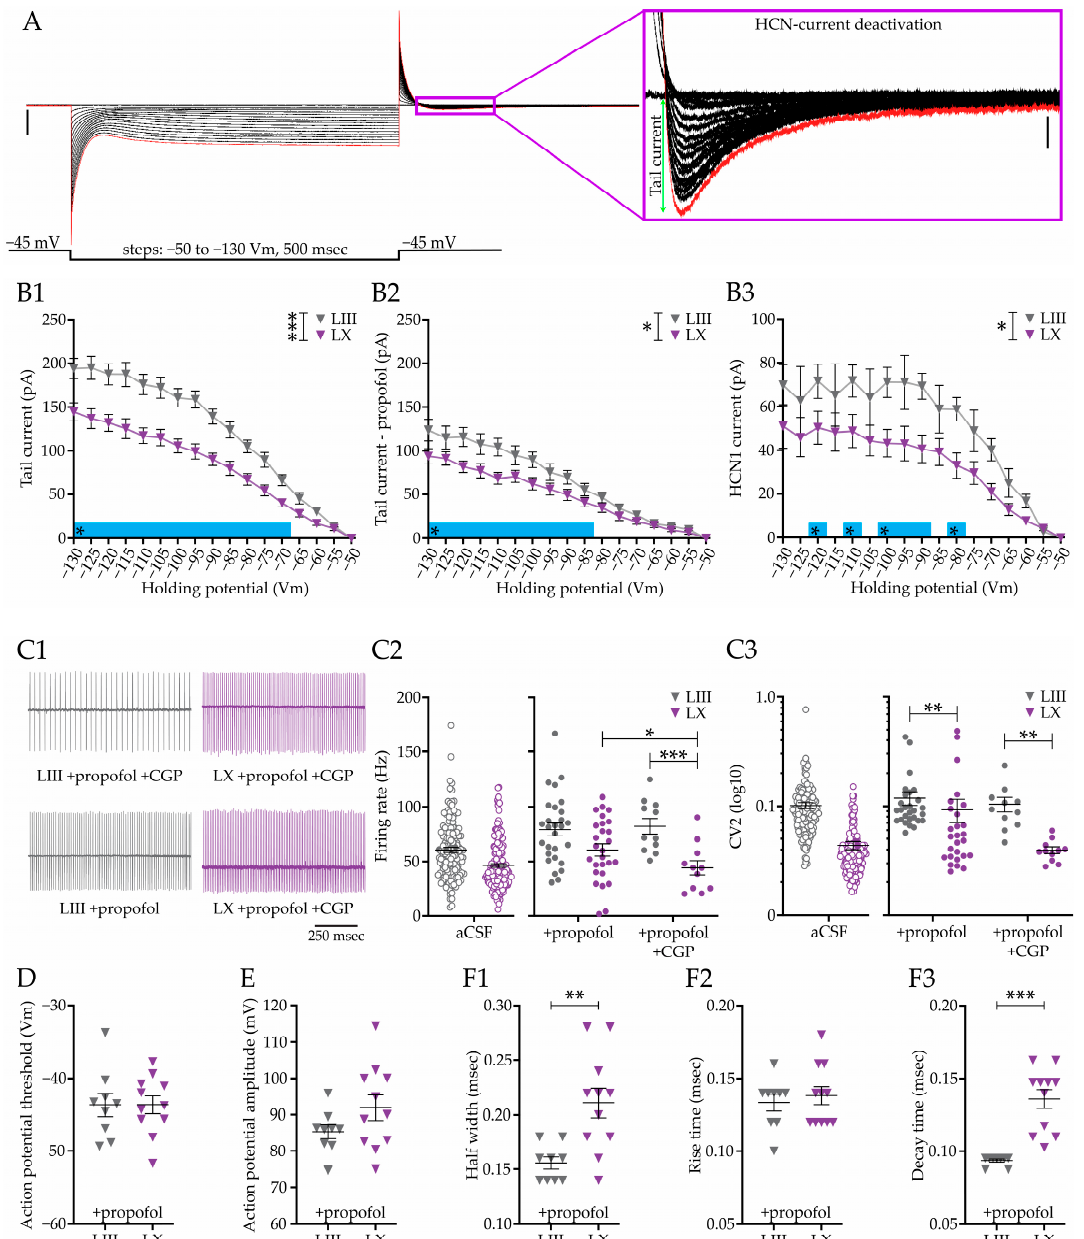
Figure 7. HCN currents in subpopulations of cerebellar Purkinje cells. ( A ), Analysis of HCN currents by holding PCs at − 50 mV and imposing voltage steps, ranging from − 55 to − 130 mV, and calculating the amplitude of the release-evoked tail currents. ( B ), Tail currents analysis comparing the responses in PCs from LIII and LX of >P30 mice in normal aCSF ( B1 ) and after adding HCN1 blocker propofol ( B2 ). Subtraction of the B2 from B1 gives an indication of the amplitude of the HCN1 current ( B3 ). ( C ), Effect of inhibiting HCN1 on PC firing properties using propofol and propofol + CGP, visualized by example traces ( C1 ), analysis of the firing rate ( C2 ) and the local coefficient of variance (CV 2 , ( C3 )). ( D – F ), Analysis of the effects of propofol on action potential threshold ( D ), AP amplitude ( E ), half width ( F1 ), rise time ( F2 ), and decay time ( F3 ) in PCs from LIII and LX. See Figure 1 for comparison. Vertical scale bar in A 1000 pA; A-insert HCN-current deactivation 50 pA. Asterisks denote: * for p < 0.05, ** for p < 0.01 and *** for p < 0.001. Table S7 for all statistical